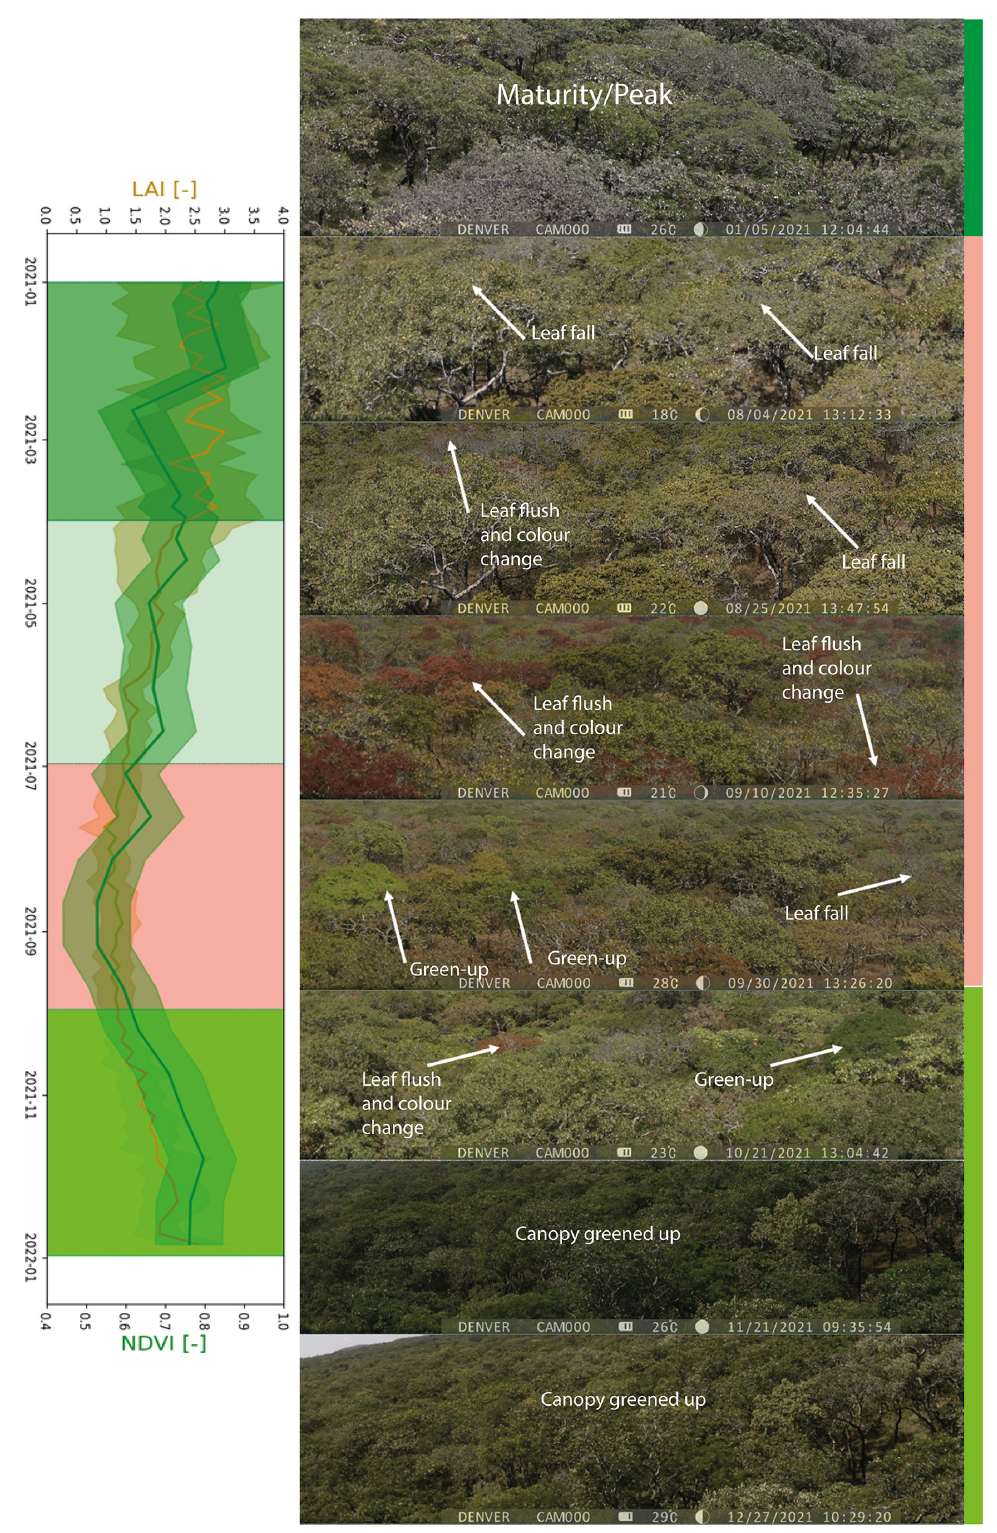
Figure 9. Selected aerial view images of the upwind direction (east direction) above the canopy from the flux tower across phenophases from January–December 2021. Shaded boxes are the phenophases: peak/maturity (January–March), senescence/green-down (April–June), dormant (July–September), and green-up (October–December). The satellite-based NDVI and LAI appear to agree with the changes in the canopy cover. Shading in variables LAI and NDVI is the minimum and maximum